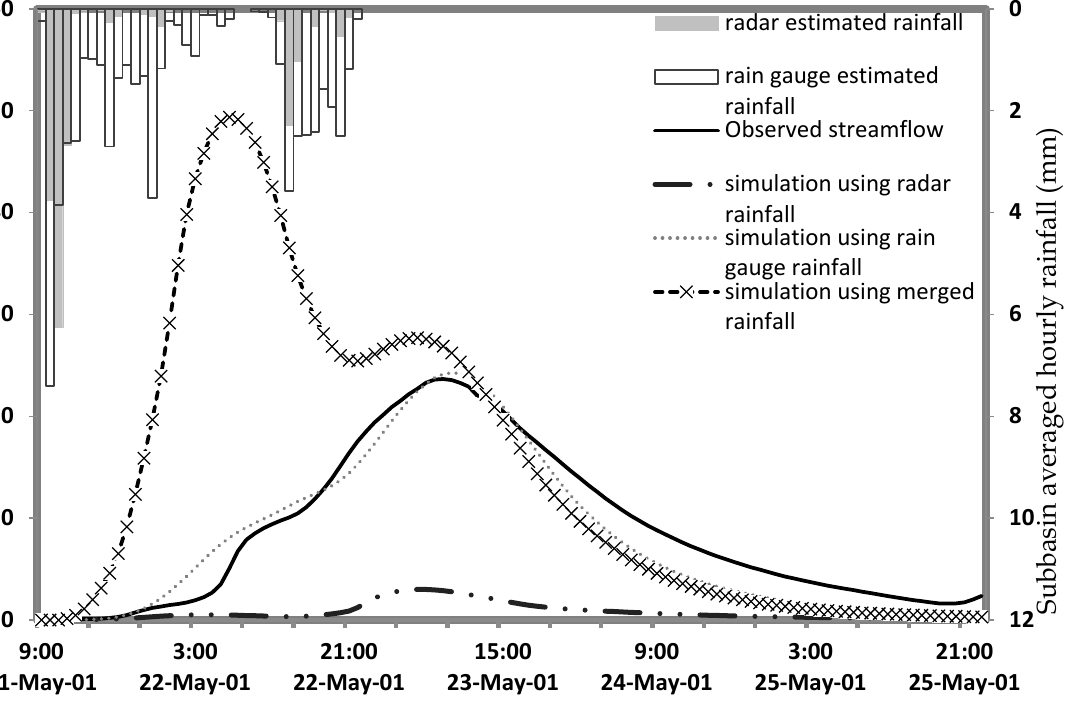
Figure 22. Comparison of estimated and observed hydrographs using different rainfall estimates for the 21 May 2001 event with Green and Ampt modeling option.